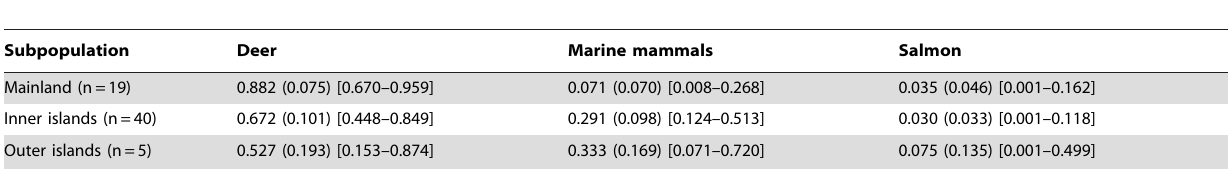
Table 2. Posterior estimates of diet proportions by region (subpopulation) for a coastal grey wolf population in British Columbia